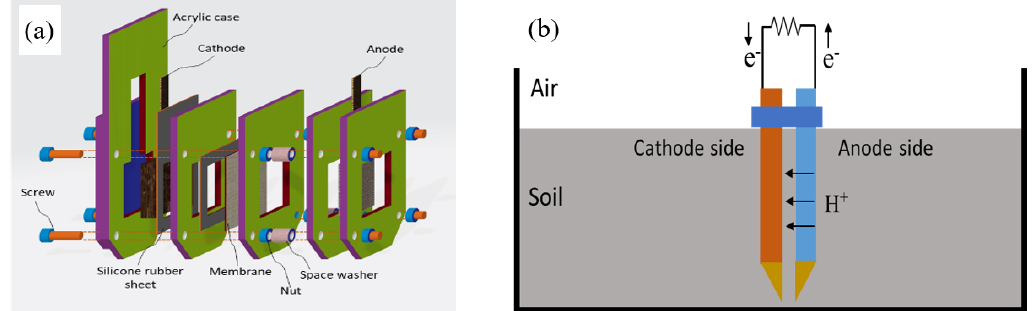
Figure 1. ( a ) Schematic of the plugged-type soil microbial fuel cell (PSMFC) structure and ( b ) schematic diagram of the experimental setup.